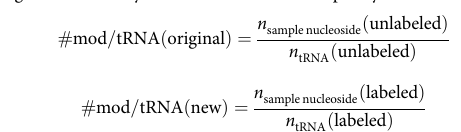
Table S4 gives a summary of the calculations exemplarily for m 7